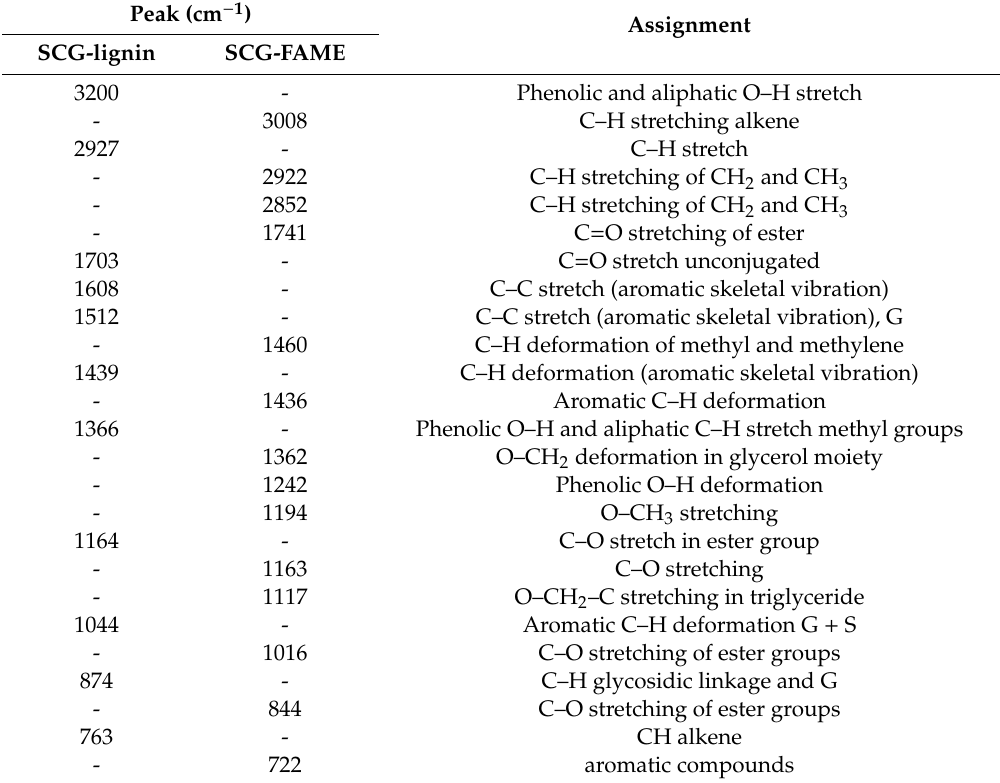
Table 4. Assignment of FT-IR spectra of SCG-lignin and SCG-FAME from